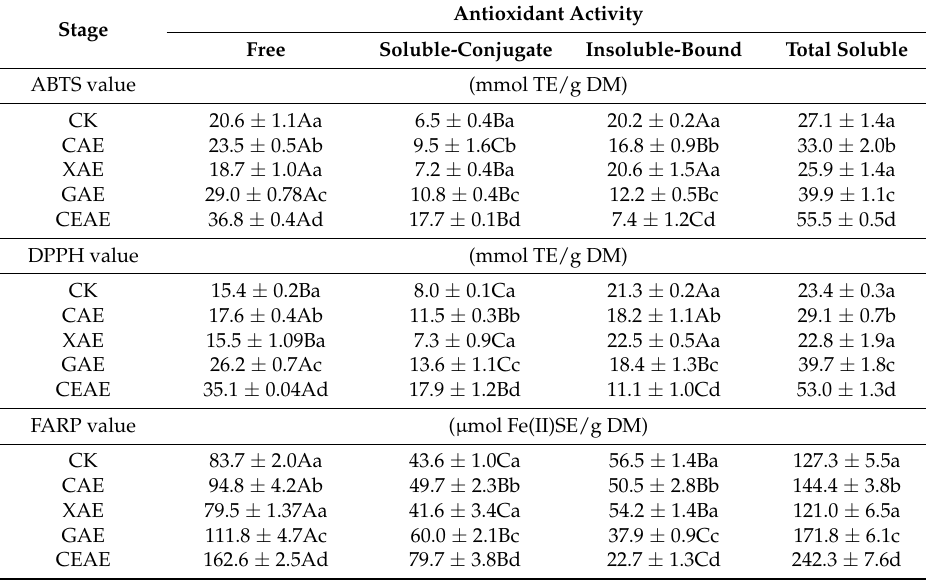
Table 2. Antioxidant activity of the free, soluble-conjugate, insoluble bound, and total phenolics fractions of guava leaves following different enzyme-assisted